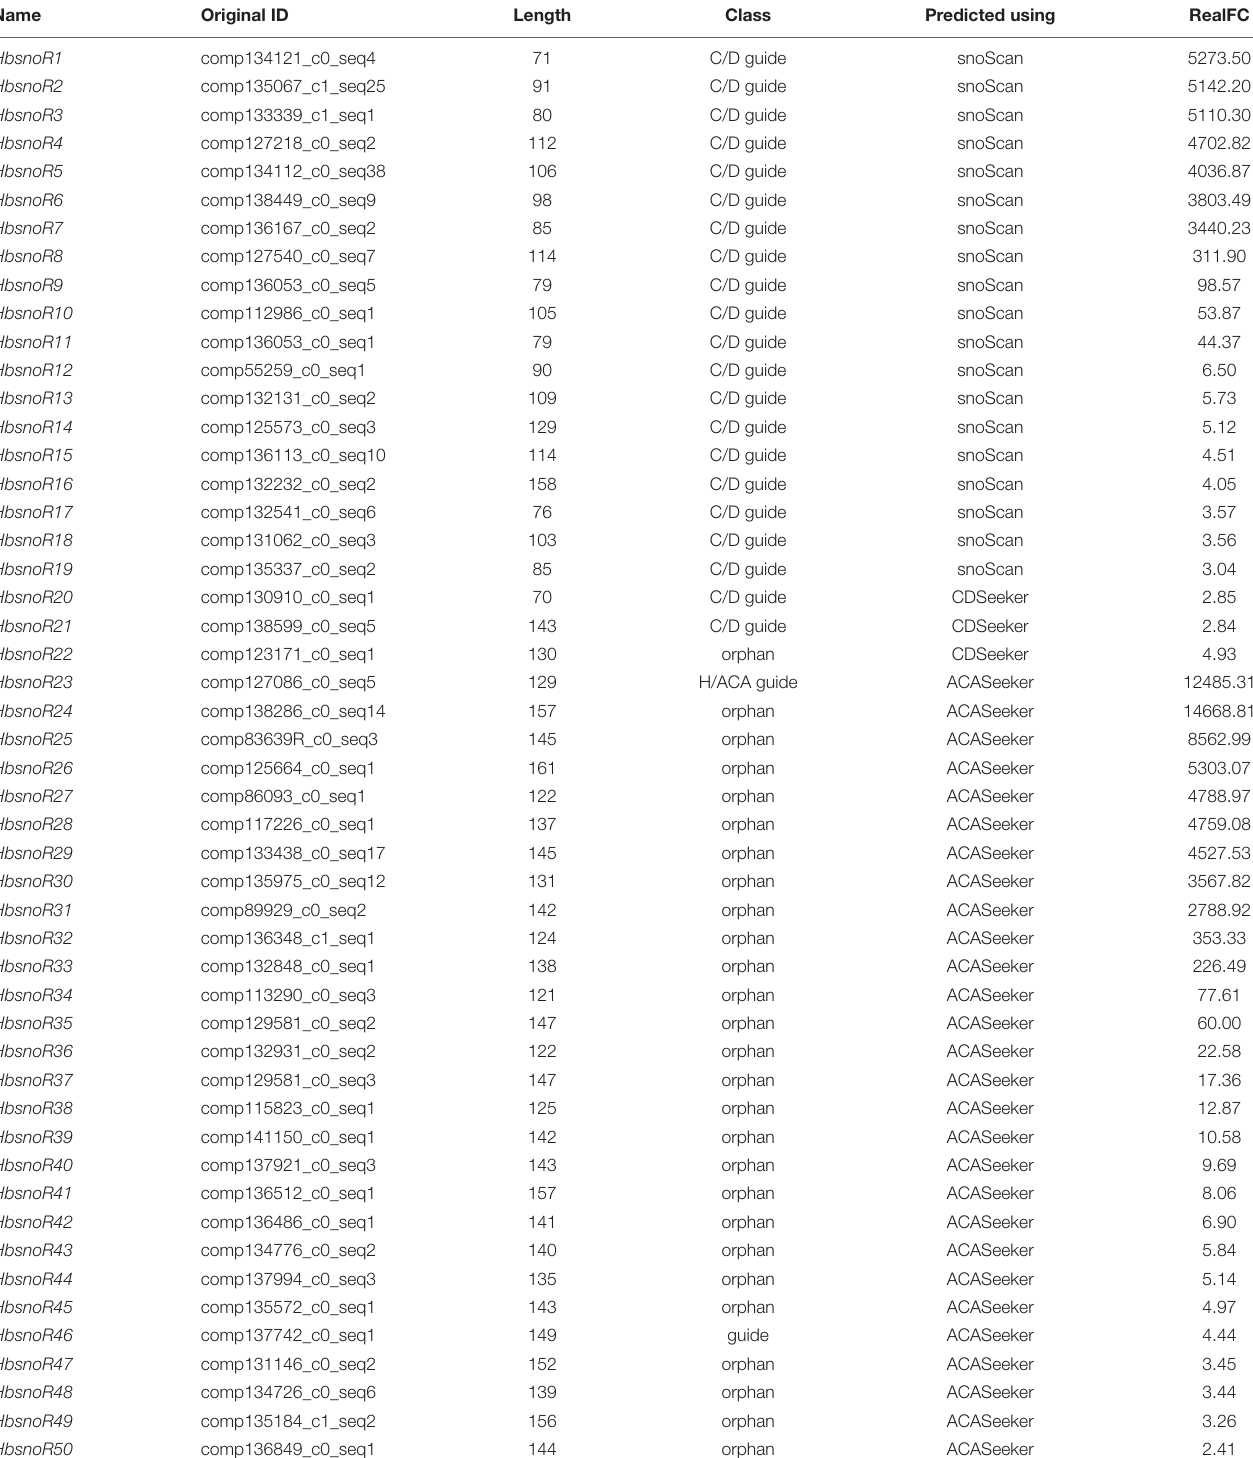
TABLE 3 | List of 50 laticifer-abundant expressed small nucleolar RNA (snoRNA) candidates in Hevea